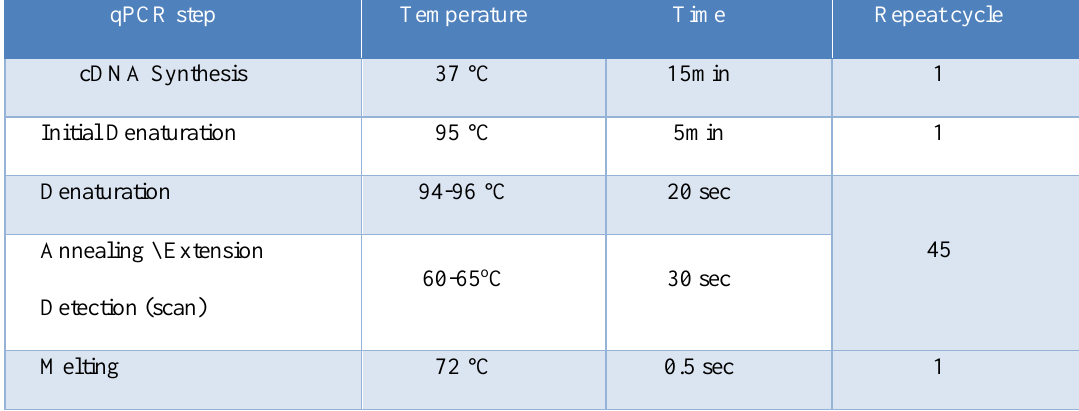
Table,3: The protocol real-time PCR